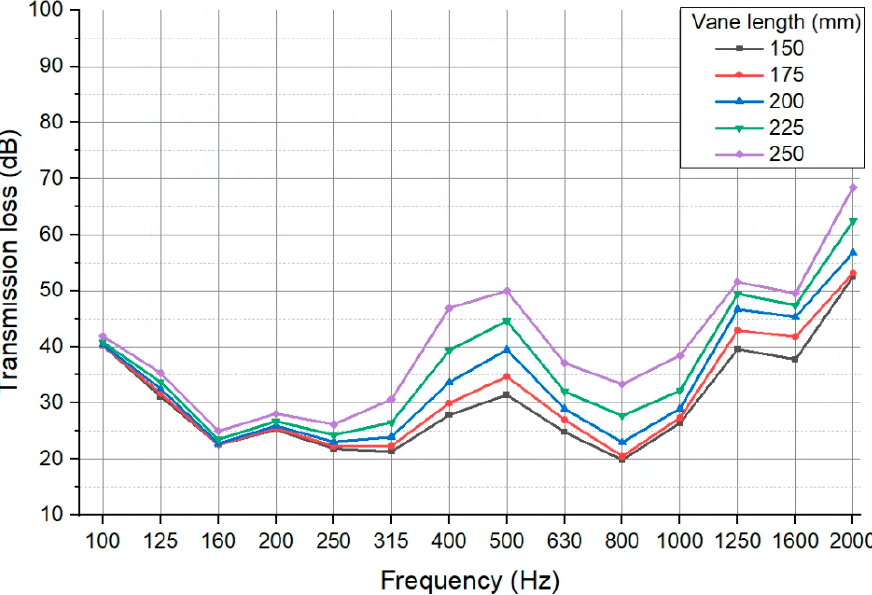
Figure 12. Transmission loss according to the vane length in the inner vane reverse type.